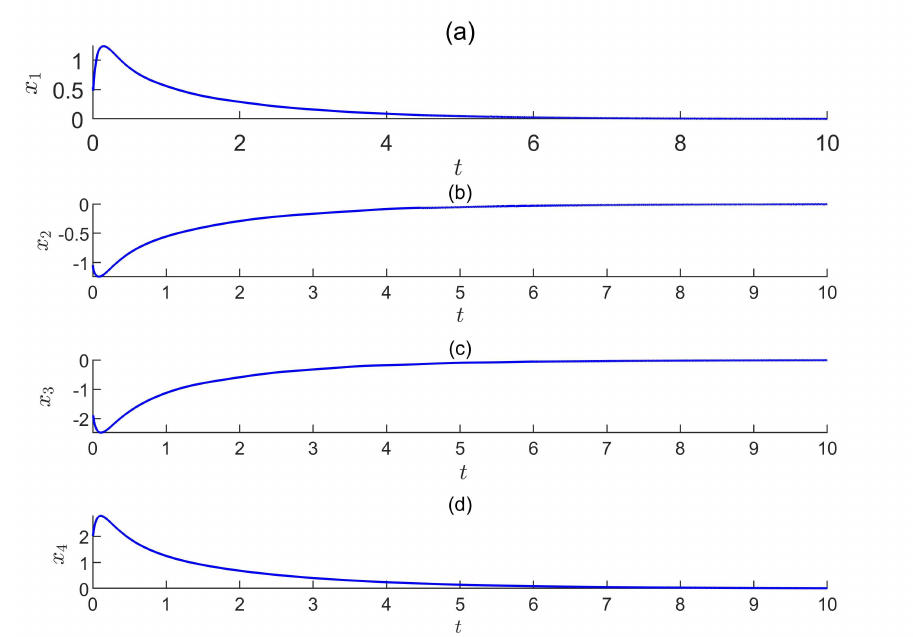
Figure 3. The control input signals of the system: ( a ) the u 1 − t space; ( b ) the u 2 − t space; ( c ) the u 3 − t space; ( d ) the u 4 − t space.